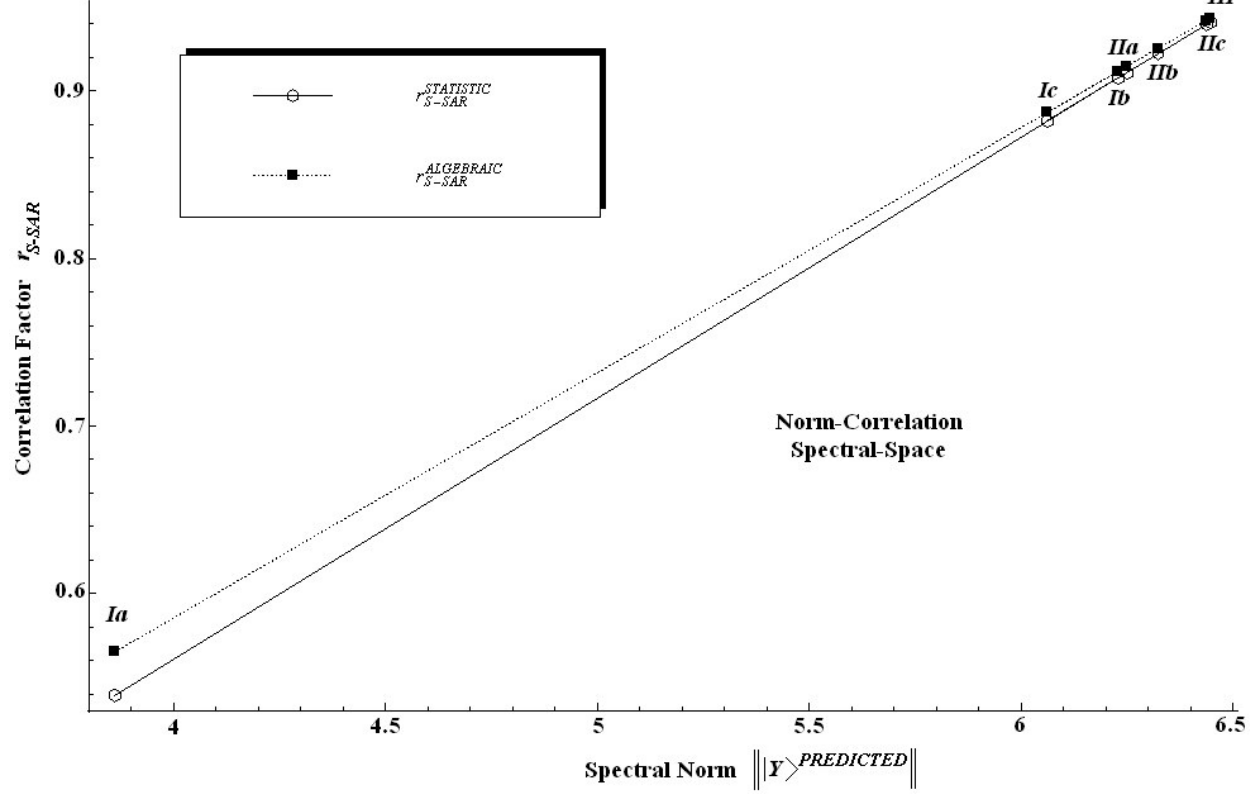
Figure 4. Norm correlation spectral space of the statistical and algebraic correlation factors against the spectral norm of the predicted S-SAR models of Table 6, respectively. Table 7. Synopsis of the statistic and algebraic values of paths connecting the S-SAR models of Table 5 in the norm-correlation spectral-space of Figure